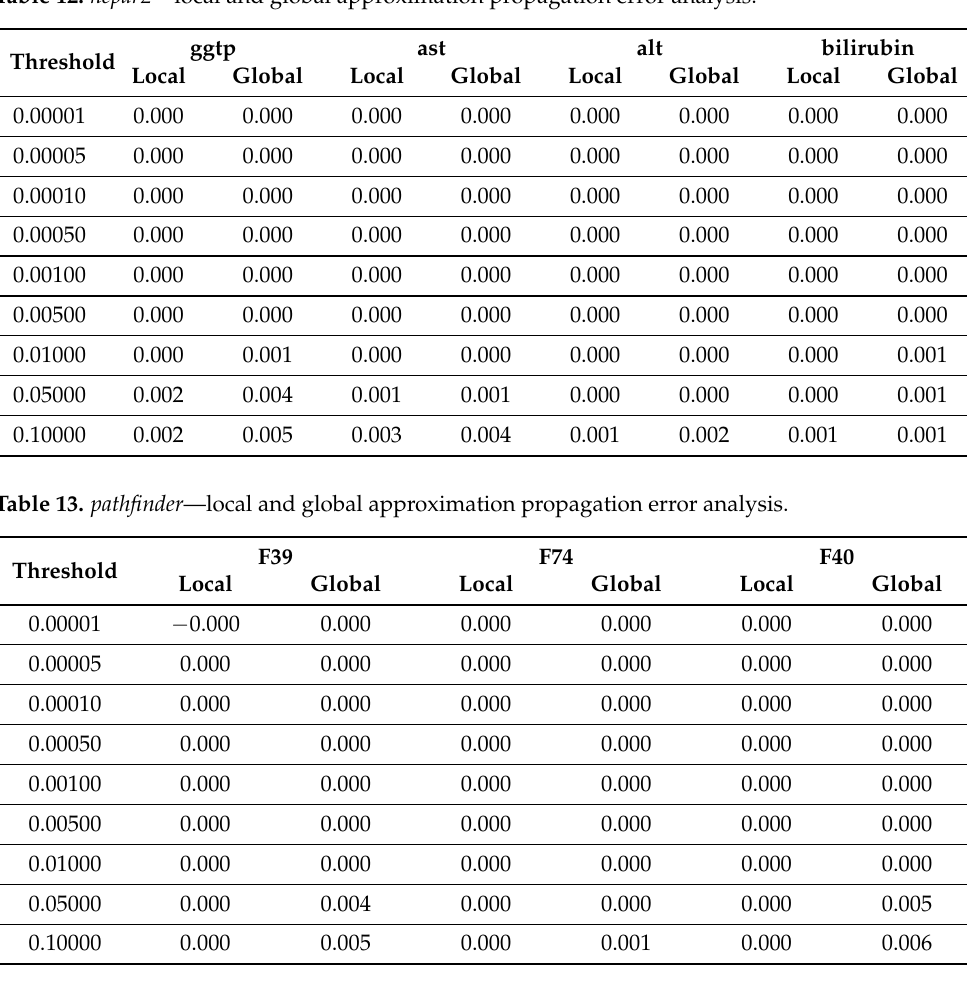
Table 12. hepar2 —local and global approximation propagation error analysis.